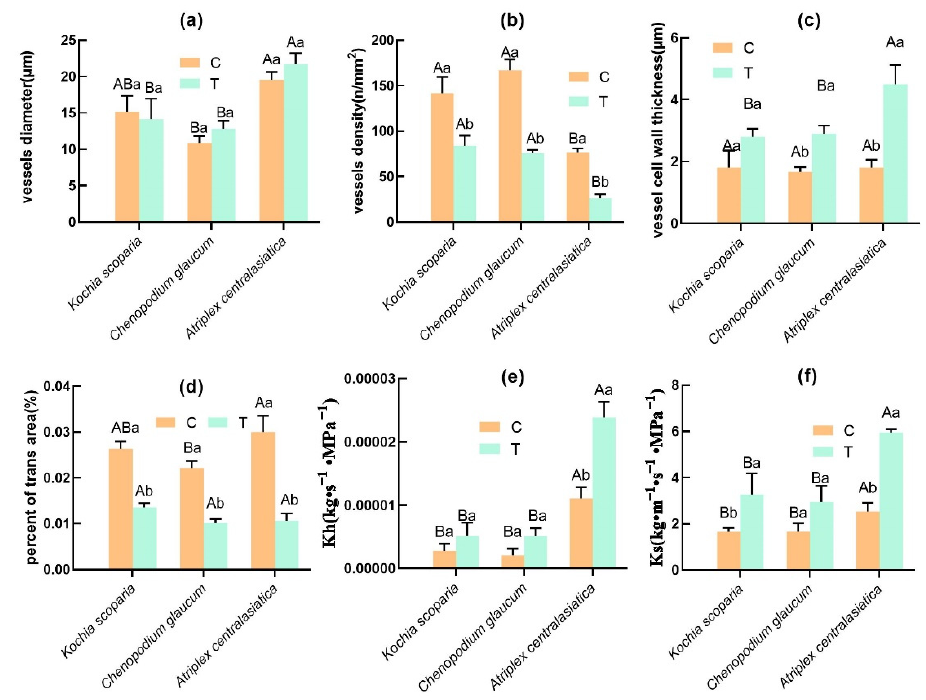
Figure 5. Changes in hydraulic and anatomical parameters of three plant species under tailings stress. Bars indicate mean ± SD ( n = 3). Different capital letters indicate significant differences between groups (between different plants) and different lowercase letters indicate significant differences within groups (control and treatment of the same plant) using the Tukey test ( p < 0.05). C represents the control group; T represents the experimental group. ( a ) Effects of heavy metals on vessels diameter of the three plants. ( b ) Effects of heavy metals on vessels density of the three plants. ( c ) Effects of heavy metals on vessels cell wall thickness of the three plants. ( d ) Effects of heavy metals on percent of trans area of the three plants. ( e ) Effects of heavy metals on Kh of the three plants. ( f ) Effects of heavy metals on Ks of the three plants.